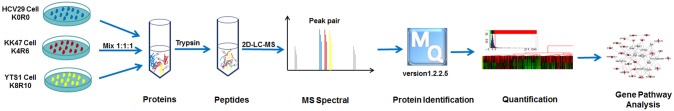
Schematic procedure for quantitative analysis of proteins in BC cells vs. normal bladder cells.